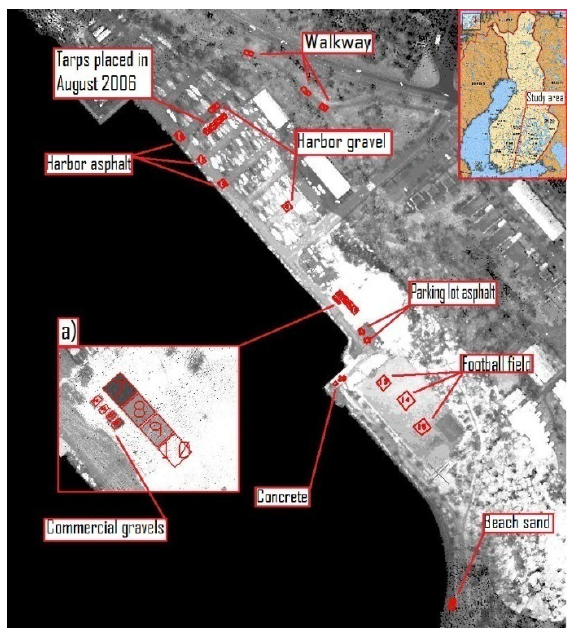
Figure 1. Lidar raw intensity image from a December 2006 flight. Placement of natural and commercial samples near Espoonlahti Harbor. (a) Tarps and commercial gravel during the December 2006 flights. Tarps from top to bottom: 5%, 25%, 30% and 45% nominal reflectance. Commercial gravel from top to bottom: Sanding Gravel, Yellow Quartz, Black Diabase and LECA.